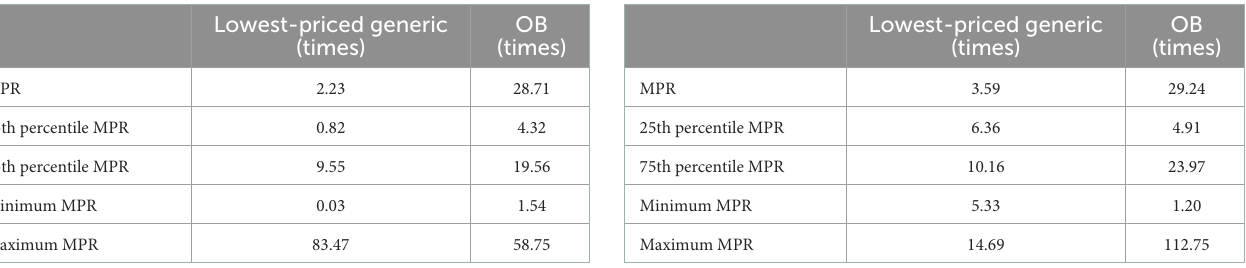
TABLE 3 Prices in the public sector compared to international reference prices.